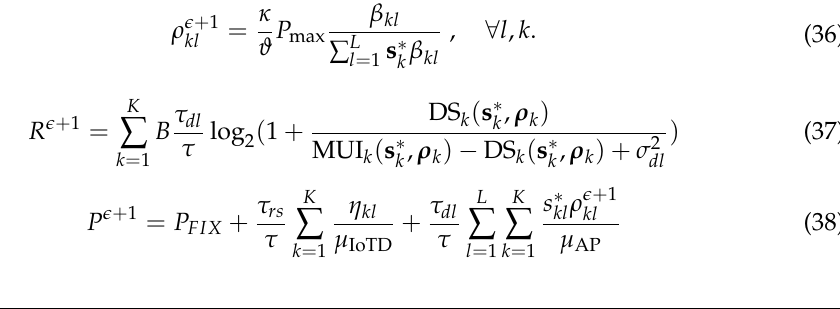
Algorithm 2 KM-based AP selection and Partial Power Allocation